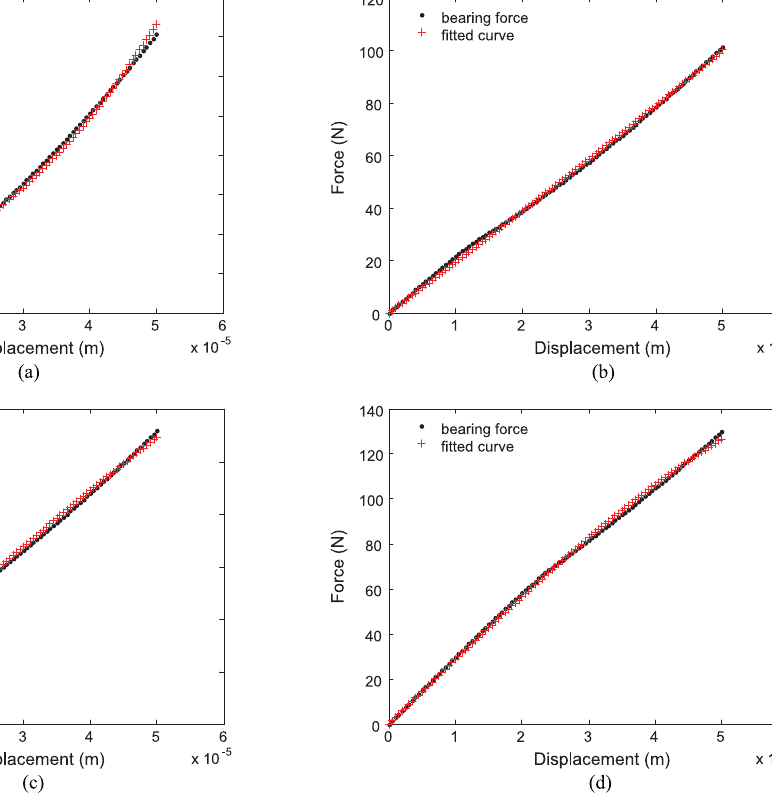
Fig. 5. Force-displacement relationship under different preloads, (a) F a = 0 N, μ b = 3.08 × 10 8 , k b = 8.3 × 10 5 N/m, (b) F a = 5 N, μ b = 8.03 × 10 7 , k b = 1.5 × 10 6 N/m, (c) F a = 15 N, μ b = − 1.82 × 10 7 , k b = 2.3 × 10 6 N/m, (d) F a = 25 N, μ b = − 4.85 × 10 7 , k b = 2.9 × 10 6